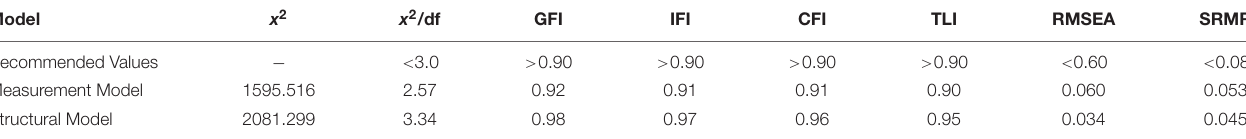
TABLE 2 | Measurement model fit indices.